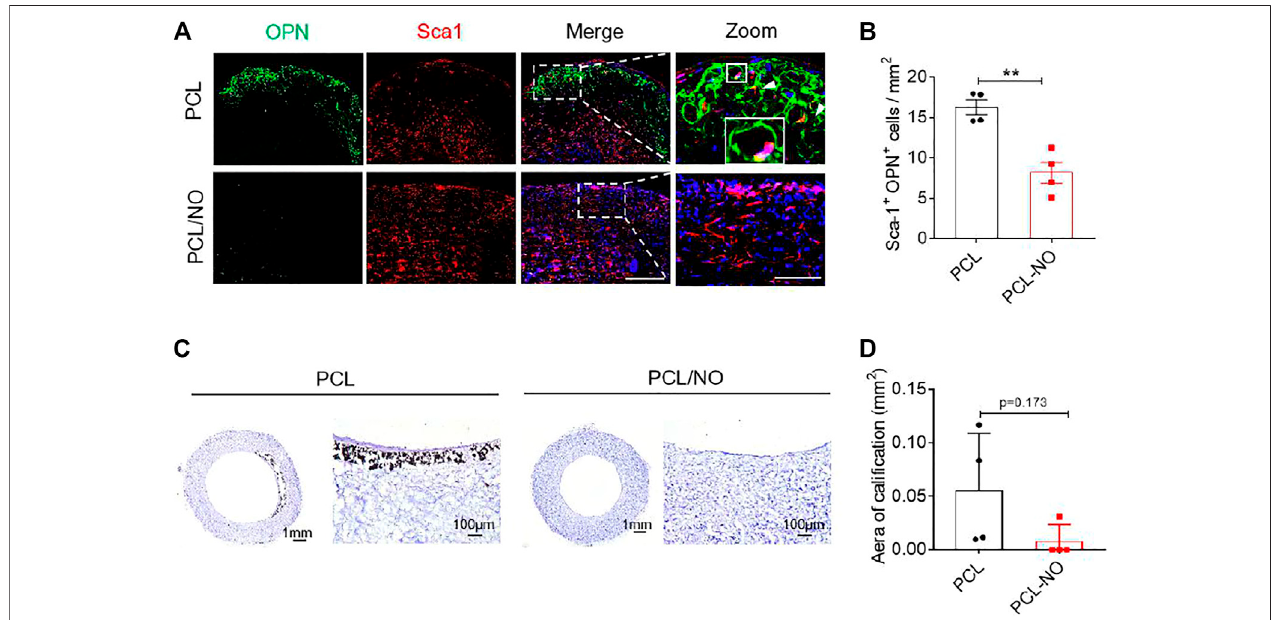
FIGURE6| SustainedNOreleasefromnitrate-functionalizedSDVGsinhibitsvascularcalci fi cation. (A) Immunohistochemicalstainingofcrosssections(scalebar (cid:1) 100 µm) for OPN (osteogenic cells, green) and Sca-1 (vascular progenitor cells, red). White boxes indicate area of magni fi ed images (scale bar (cid:1) 20 µm), white box showsareaofinsetenlargedimageofpositivestainingaroundaPCLmicro fi ber. (B) Quanti fi cationofSca-1 + /OPN + cellsper1 mm 2 areaat3 monthspost-implantation. (C) Histochemical staining of SDVG (left panels, scale bar (cid:1) 1 mm; right panels, scale bar (cid:1) 100 µm) sections with Von Kossa stain to visualize calci fi ed plaque formation. (D) Quanti fi cation of the area of calci fi cation present in SDVG sections at 3 months post-implantation. Images and data are representative of n (cid:1) 4 independent